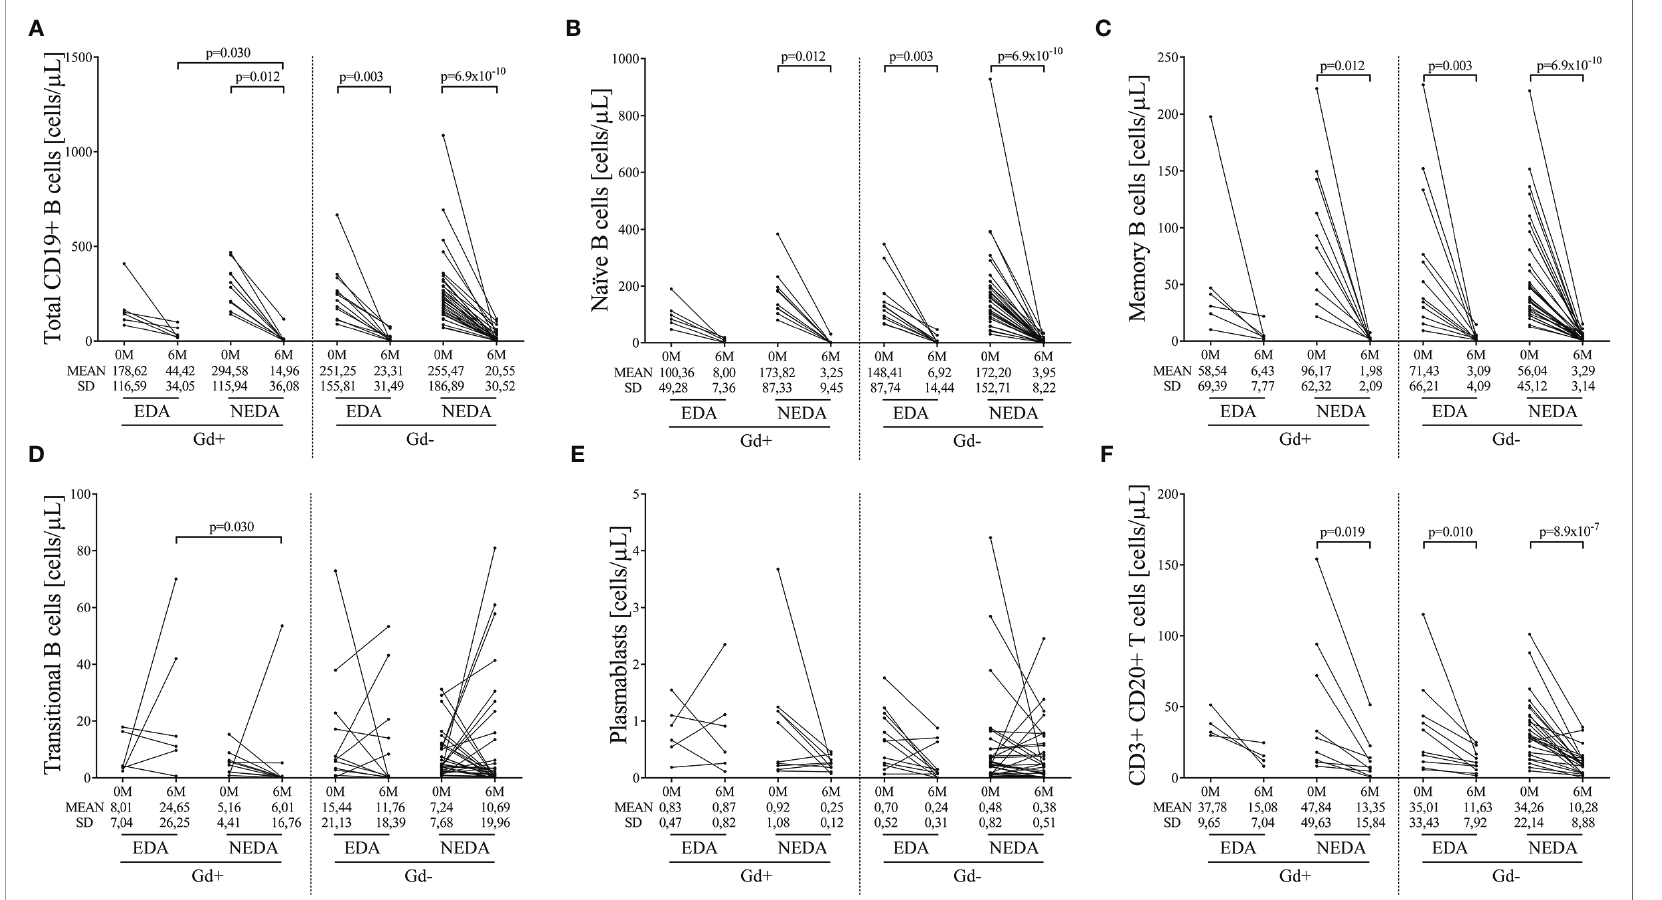
FIGURE 1 | Changes in blood B cell subsets induced by ocrelizumab treatment. Total and B-cell subsets were obtained before (0M) and at 6 months (6M) of ocrelizumab treatment and classi fi ed based on their in fl ammatory status (presence [Gd+] or absence [Gd-] of gadolinium enhancing lesions at baseline) and response (optimal NEDA or suboptimal EDA) to treatment at one year of follow-up. N was 6, 10, 12 and 41 in Gd+ EDA, Gd+ NEDA, Gd- EDA and Gd- NEDA, respectively. Graphs showing changes in absolute numbers (cells/ m L) of total CD19+ B cells (A) , naïve B cells (B) , memory B cells (C) , transitional B cells (D) , plasmablasts (E) and CD20 T cells (F) . SD, Standard deviation. Bonferroni-corrected p-values are